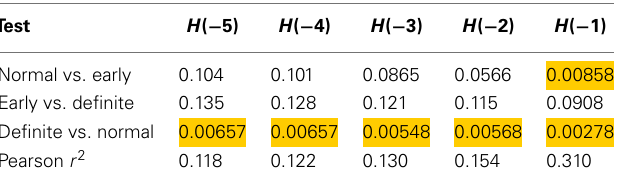
( λ ) and smaller Gaussian kernel smoothing with 43% of the vari- ance explained by the SD for discrimination between any of the groups with H ( −